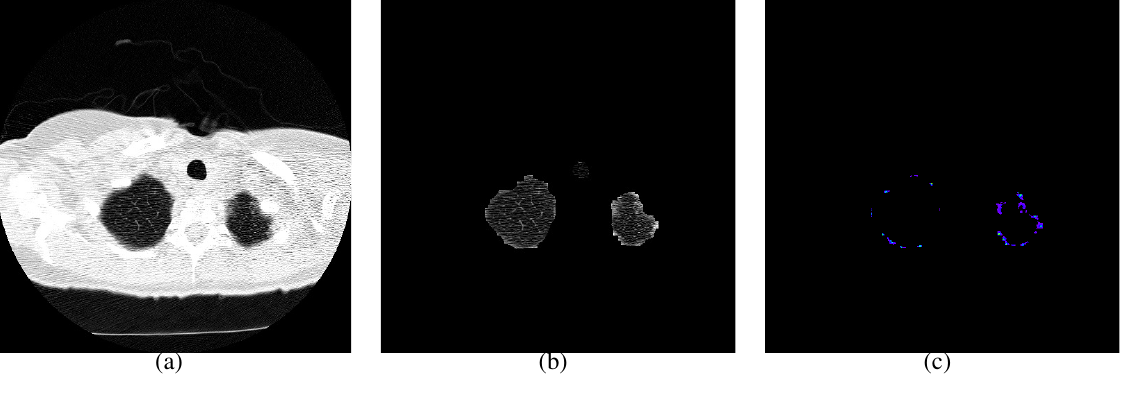
Figure 15. The failure of the lung region extraction generates false positives. ( a ) Original slice section. ( b ) Extracted lung region. ( c ) Result of the initial detection.